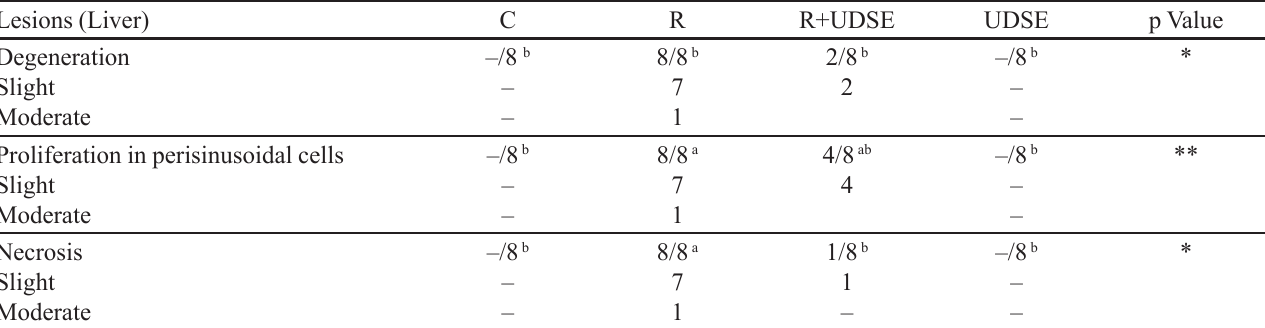
The Values with sign are significantly different (P < 0.05), according to the Tukey T test. (*p<0.05): according to the other groups, ( ≠ p<0.05): according to the C and UDSE groups, ( ɸ p<0.05): according to the R and R+UDSE groups. AST: aspartate aminotransferase; ALT: alanine aminotransferase; MDA: malondialdehyde: SOD: superoxide dismutase; CAT: catalase; GSH: reduced glutathione; GSH-Px: glutathione peroxidase; Groups: C; control, R; radiation group, R+UDSE; radiation+ Urtica dioica seed extract group, UDSE; Urtica dioica seed extract group. TABLE III - Observational comparison of the effects of UDSE and radiation on the hepatic structure formation Lesions (Liver)